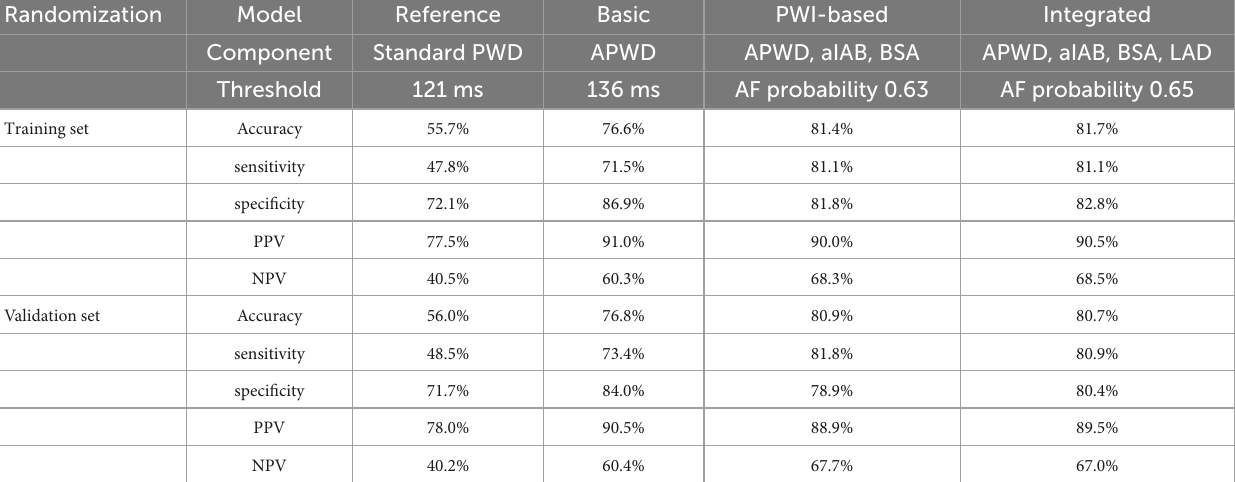
TABLE 3 Optimal thresholds in models with diagnostic performance. Randomization